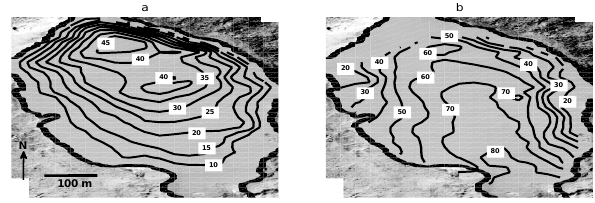
Fig. 7. Lake bathymetry (m) (a) and ice thickness distribution (m) on 20 August 2000 (b) ; the photograph in the background corre- sponds to the state of the lake in 2009; the thick black line indicates the lake